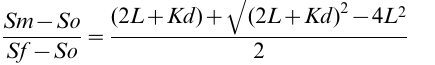
Figure S2 Titration of c -secretase activity using potent c -